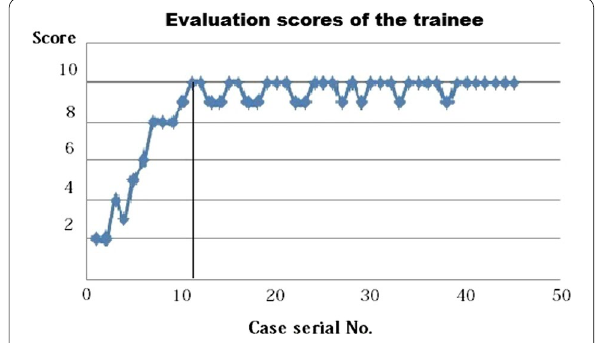
Fig. 2 A relatively steep curve of the evaluation scores of the trainee during training phase with a plateau at the 10th case, revealing a rapid acquisition of anatomical and setup orientation. The score ranged between 2 and 10 with an overall mean of